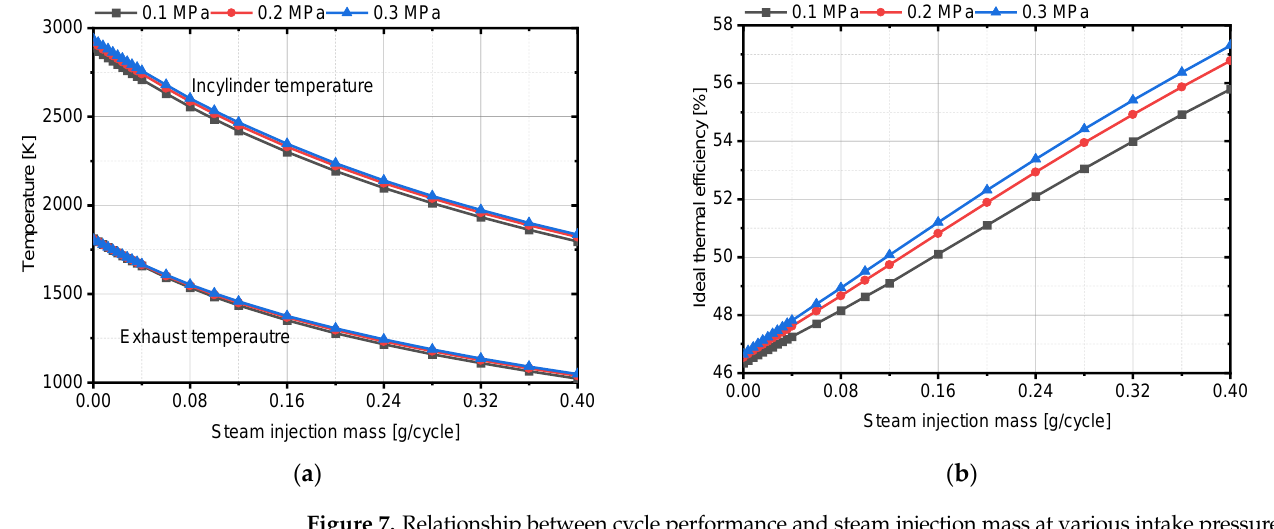
Figure 7. Relationship between cycle performance and steam injection mass at various intake pressures (T steam = 450 K; P steam = 20 MPa; CR = 10). ( a ) In-cylinder/exhaust temperatures; ( b ) Thermal efficiency.